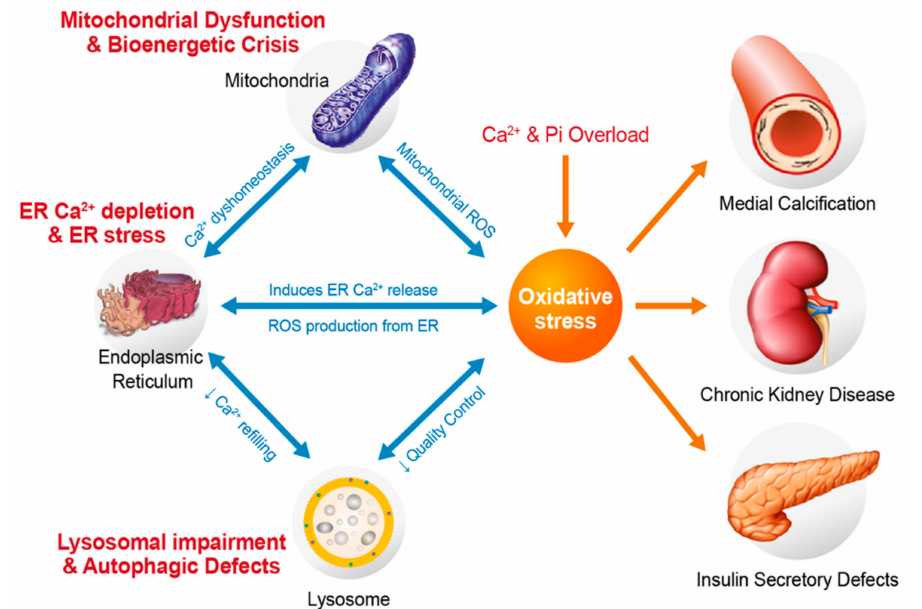
Figure 4. Oxidative stress by Ca and Pi overloads in vascular calcification. Ca and Pi overloads accelerates cytosolic and mitochondrial oxidative stress, which can induce more mitochondrial dysfunction and ER stress. Depletion of the ER Ca pool further increases ROS generation from mitochondrial and the ER, which also disturbs lysosomal Ca homeostasis and autophagy defects. All these pathologic alterations in organelles aggravate oxidative stress and disease progression including arterial medial